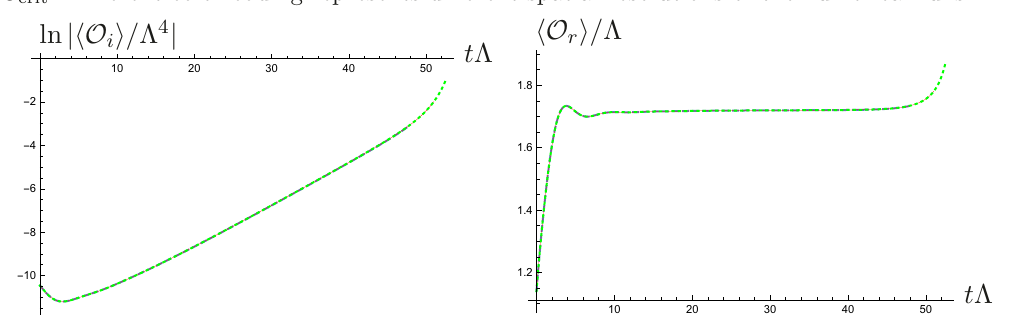
8 in the unstable regime, i.e., with −